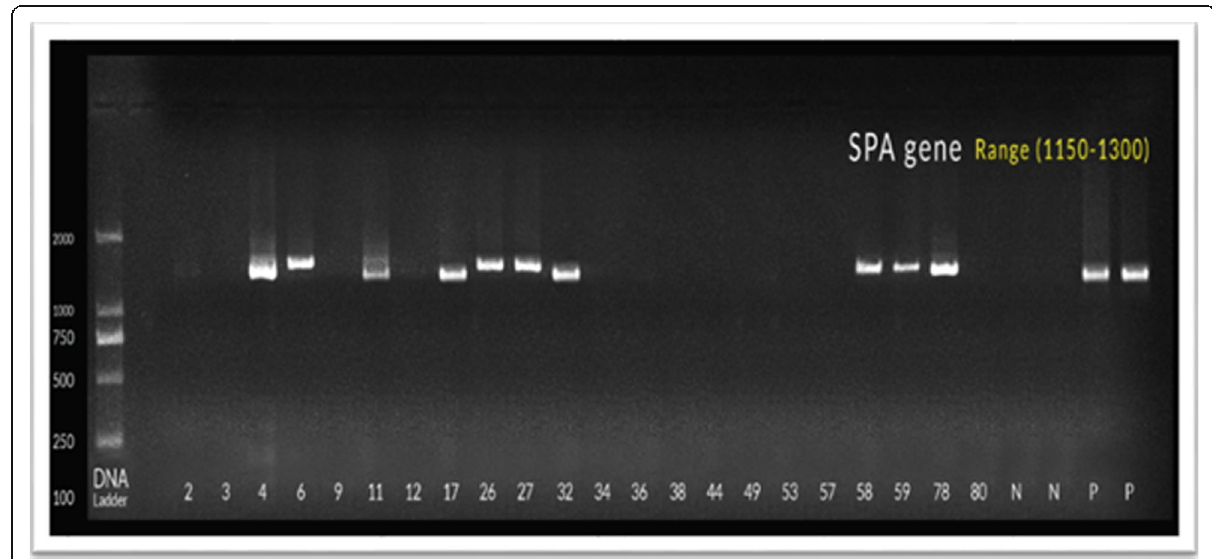
Fig. 3 Results of spa detection by PCR of 22 DNA. Twelve DNA isolated from MRSA, 5 oxacillin-R only, and 5 not oxacillin-R nor